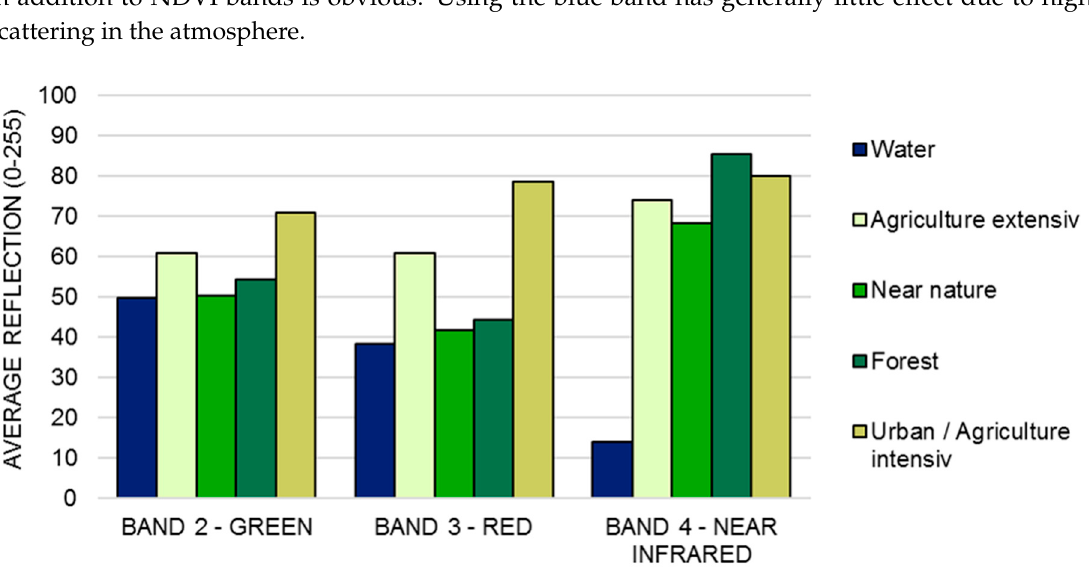
Figure 6. Average reflection of each land use class and wavelength.